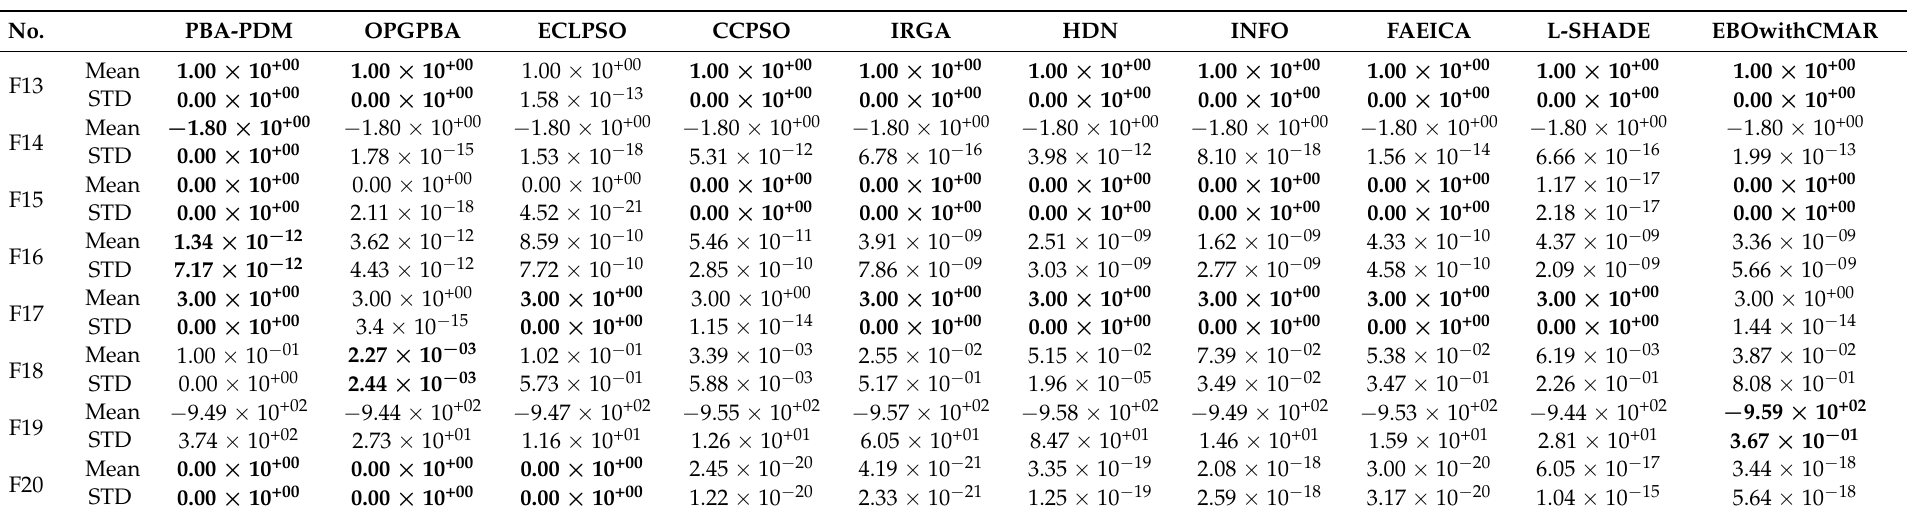
Table 5. Statistical results of the multimodal test